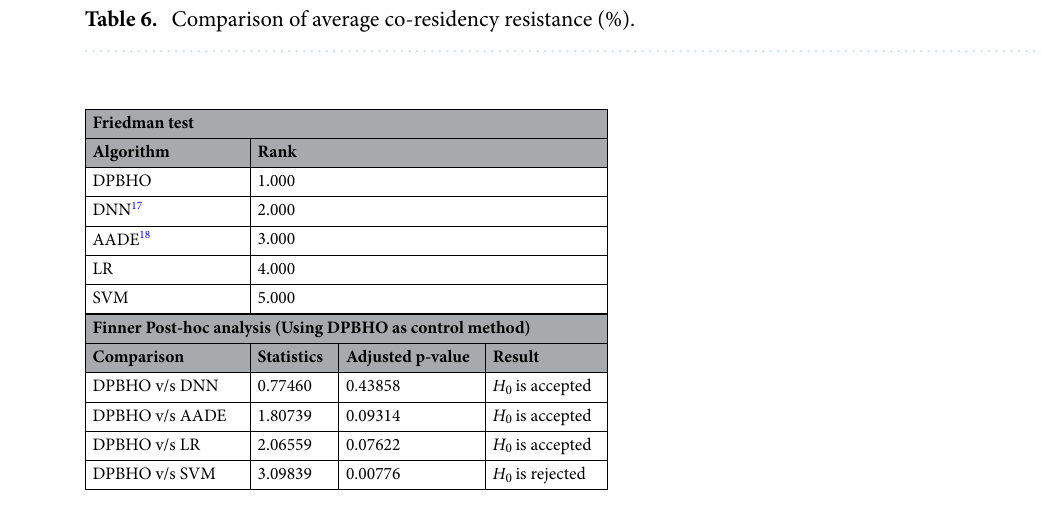
Table 7. Statistical analysis: DPBHO v/s comparative